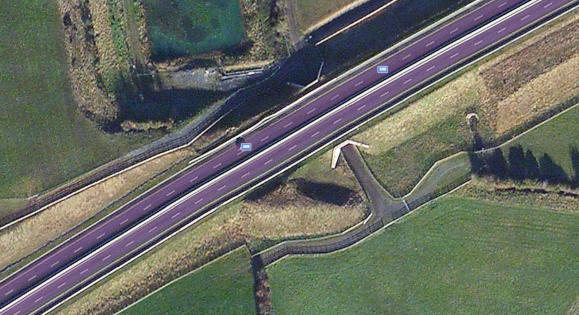
Figure 3: Bird’s eye view (Microsoft Bing Maps)